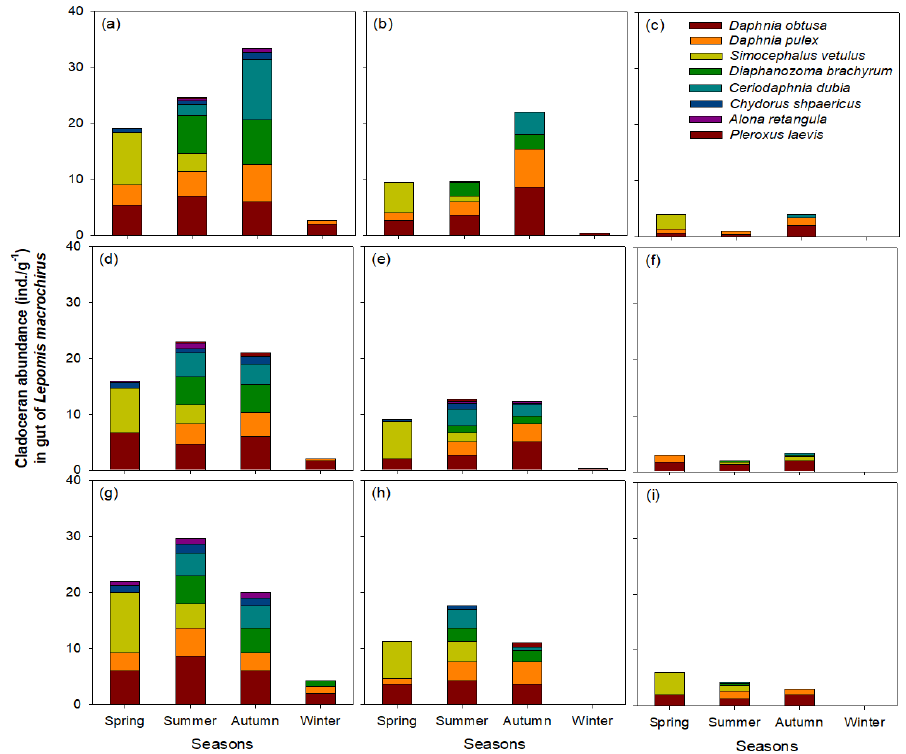
Figure 8. Seasonal food utilization of cladoceran groups by Lepomis macrochirus in three L. macrochirus size ranges (i.e., >5 cm, 6 – 10 cm, and 11 – 15 cm) based on L. macrochirus body length in three wetlands: ( a ) <5 cm body length in Upo Wetland, ( b ) 6 – 10 cm body length in Upo Wetland, ( c ) 11 – 15 cm body length in Upo Wetland, ( d ) <5 cm body length in Jangcheok Wetland, ( e ) 6 – 10 cm body length in Jangcheok Wetland, ( f ) 11 – 15 cm body length in Jangcheok Wetland, ( g ) <5 cm body length in Beongae Wetland, ( h ) 6 – 10 cm body length in Beongae Wetland, and ( i ) 11 – 15 cm body length in Beongae Wetland. Chydorus shpaericus , Alona retangula , and Pleroxus laevis are epiphytic cladocerans species, and the remaining species are